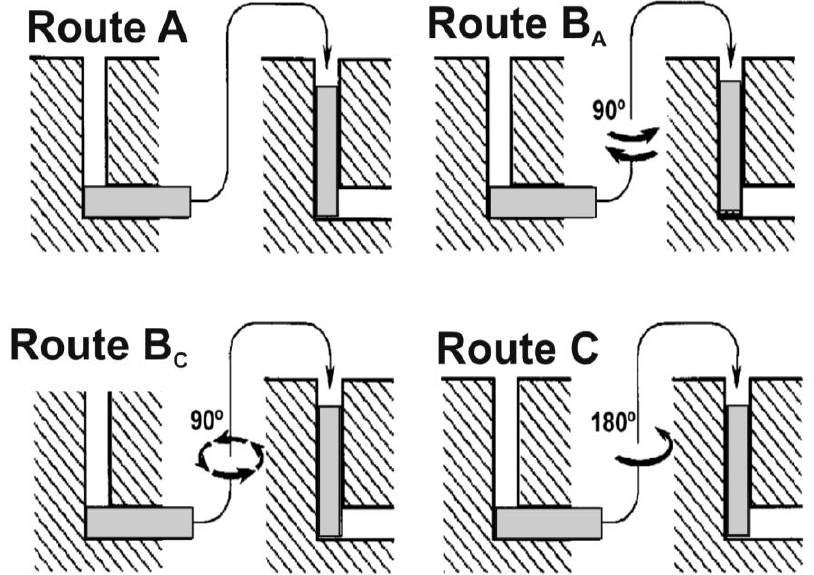
Figure 19. Various processing routes in ECAP.